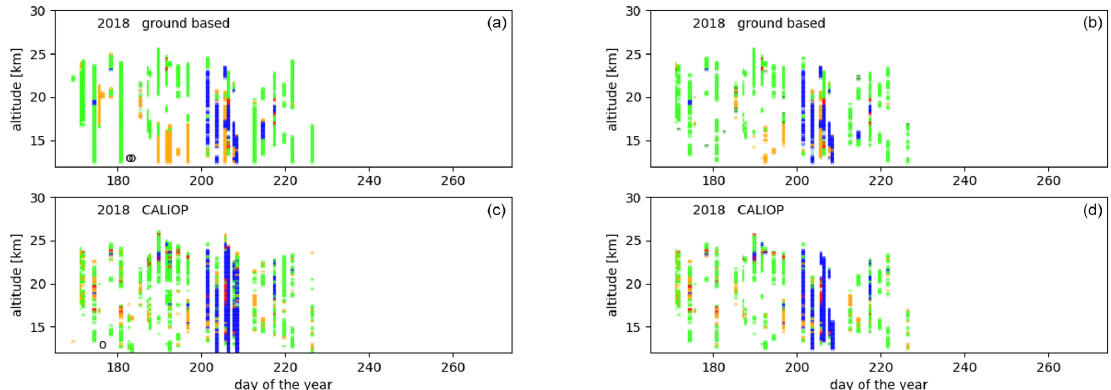
Figure 7. All quasi-coincident observations (a, c) and only those where PSCs were observed by both lidars (b, d) for 2018 above Dome C. (a, b) Ground-based lidar. (c, d) CALIOP above Dome C. The different colors indicate PSCs of different composition. Green: NAT mixtures; yellow: STS; red: enhanced NAT mixtures; blue: ice. The circles indicate measured profiles without